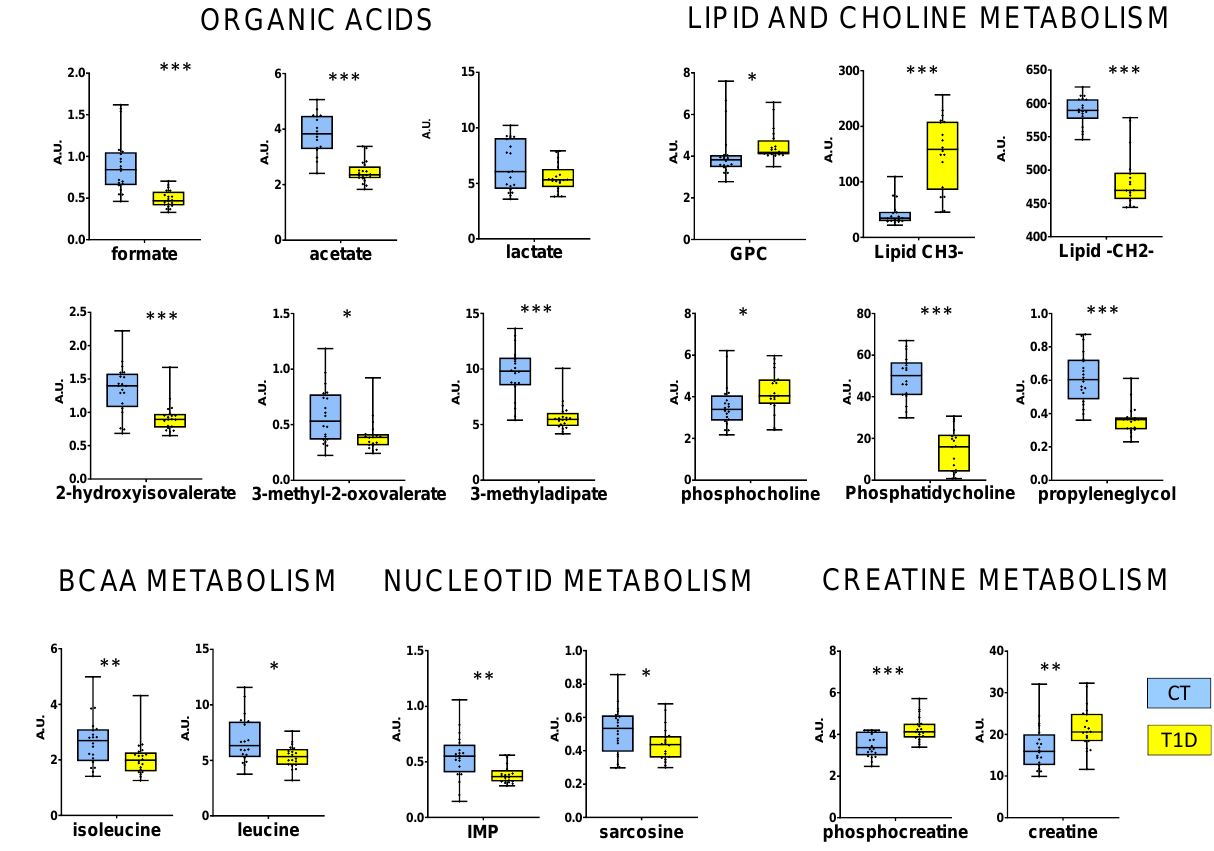
Figure 3. Box plots of RBC metabolites that showed relevant changes in T1D patients. GPC = glycerophosphocholine, CH3 = methyl group, CH2 = lipid chain, IMP = inosinic acid. Concentrations were of normalized total intensity. * = p < 0.05, ** = p < 0.01, *** = p < 0,001 in Wilcoxon test. A.U. = arbitrary units from normalized concentration values.